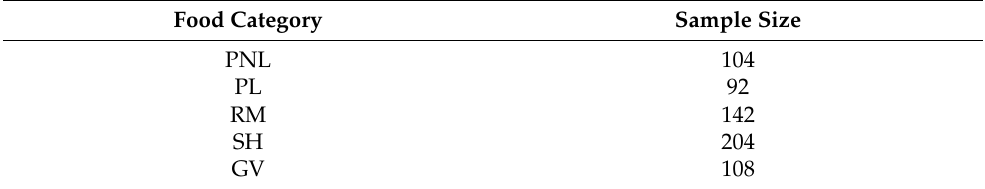
Table 2. Survey sample